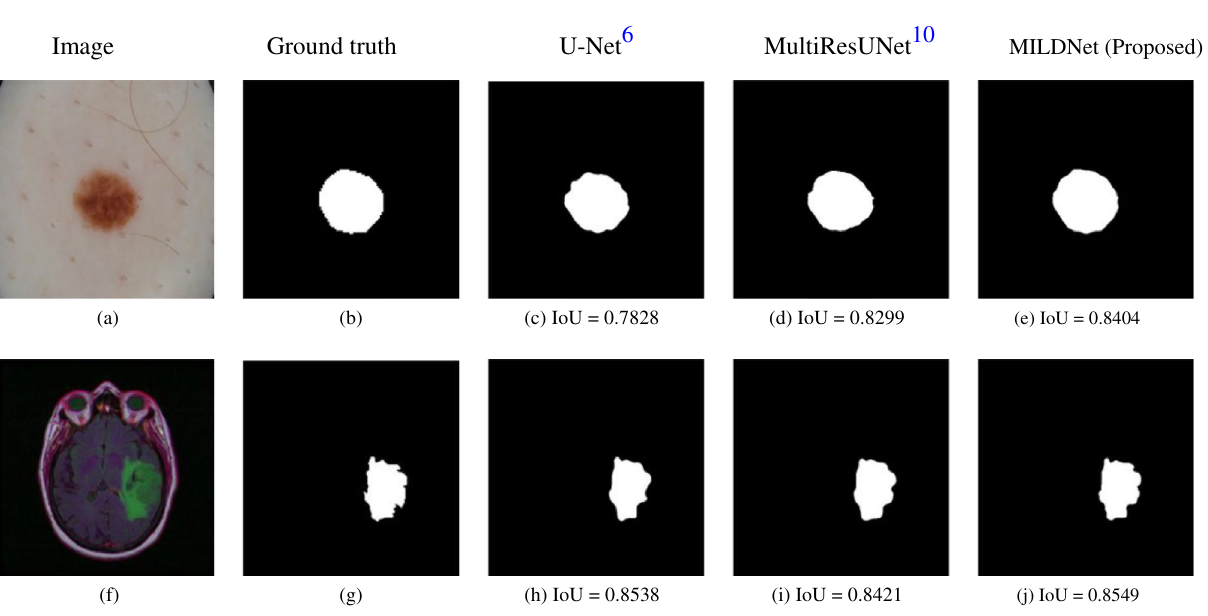
Figure 9. Segmenting a dermoscopy 11,12 image (a) and an MRI 15 image (f) having well-distinguished background and foreground, with (b,g) showing their corresponding ground truth segmentation masks. The classical U-Net (c,h) , the MultiResUNet (d,i) , and the MILDNet (e,j) performed equally well in segmenting the ROIs, close to the ground